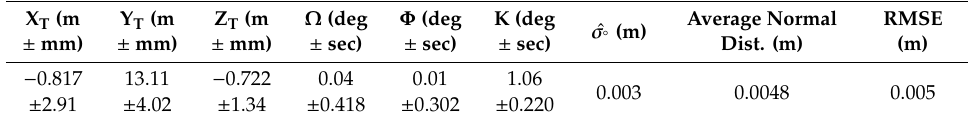
Table 4. Estimated transformation parameters and quality measures (square root of a-posteriori variance factor, average normal distance among point-patch pairs, and RMSE of the normal distances) following the registration of the TLS scans at Site-1.